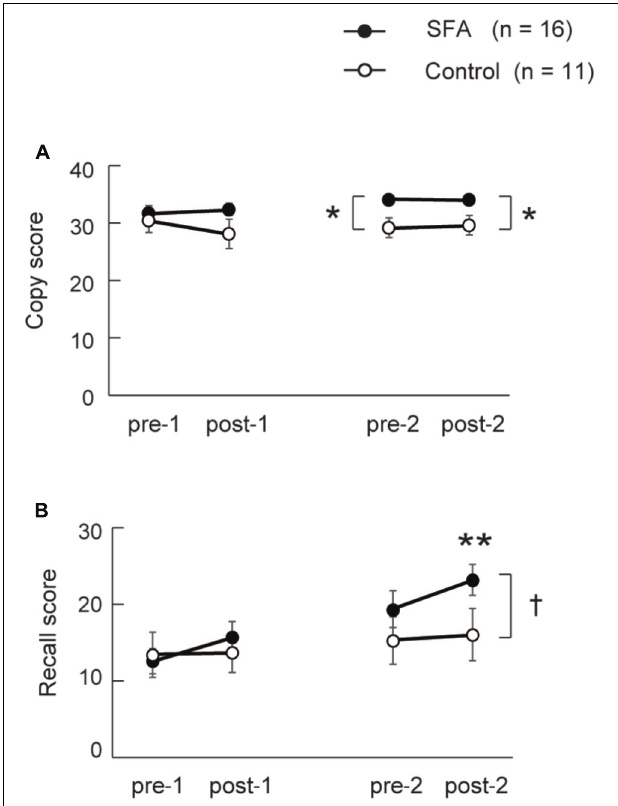
FIGURE 4 | Mean scores of the followed SFA-treated patients ( n = 11) in the Rey–Osterrieth complex figure copy (A) and recall (B) test. ∗ p < 0.05. sticks. We divided performance time by the number of materials (flowers and leaves or sticks) in each program pattern and calculated mean times required for placing each piece of material on the foam’s impression ( Table 4 ). Mean times with flowers and leaves were significantly longer than with sticks ( p < 0.01), and the time did not change within a phase.